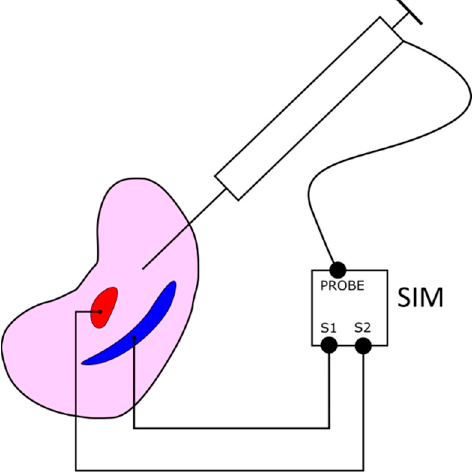
Figure 7. SIM connections. The module has three channels: for tumors (S1), vessels (S2), and syringe probe